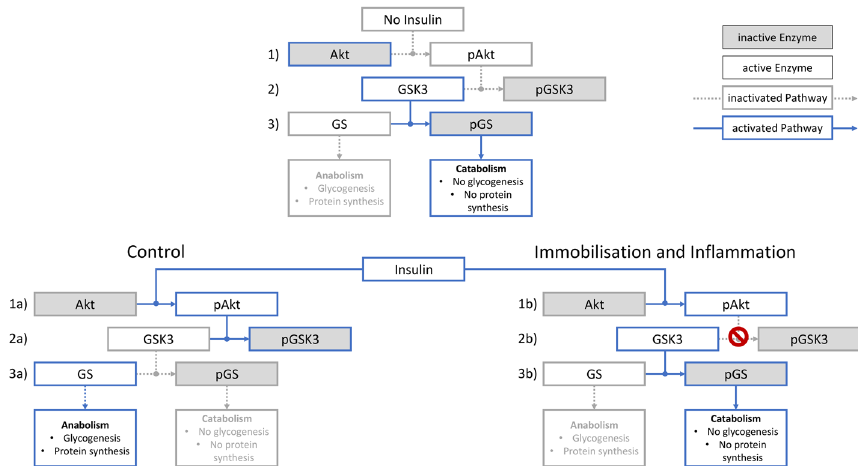
Fig. 6 Impairment of the Akt–GSK3–GS pathway in skeletal muscle. No insulin (Control and intervention groups with saline): (1) Akt in its deactivated state. (2) No inhibition through Akt, hence GSK 3 remains activated. (3) This leads to deactivation of GS via phosphorylation. group with insulin): (1a) Insulin leads to activation of Akt to phosphorylated Akt. (2a) This causes deactivation of GSK3 to pGSK3. (3a) Consequently, GS remains activated. and Inflammation (Intervention group with insulin): (1b) Insulin leads to activation of Akt to pAkt. (2b) GSK3 remains activated as inhibition via pAkt is impaired. (3b) This results in deactivation of GS to pGS. Catabolism is